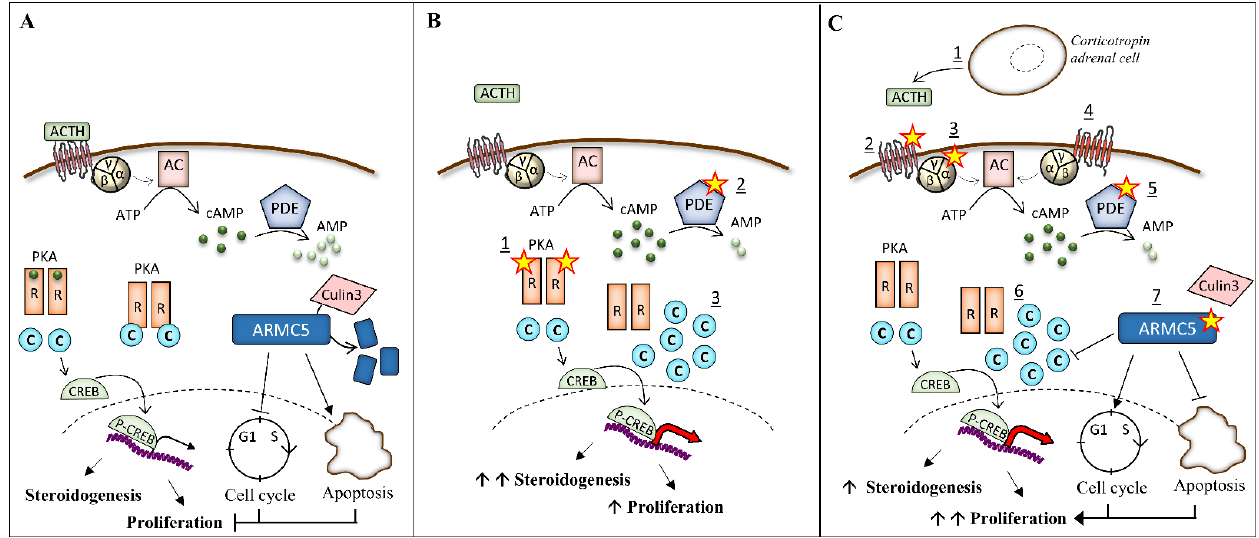
Figure 1. Alteration of protein kinase A (PKA) pathway and ARMC5 in bilateral adrenal hyperplasia. ( A ) In normal adrenocortical cells, ACTH activates the MC2R receptor, leading to the activation of the G α subunits of the G protein. The latter activates the adenylate cyclase (AC), which converts the ATP in cAMP. The phosphodiesterases (PDE) inactivates cAMP in AMP. The regulatory (R) subunits of the PKA bind the cAMP, leading to the release of the catalytic (C) subunits. The catalytic subunits phosphorylate their targets, including the cAMP Response Element-Binding protein (CREB), which activates genes involved in steroidogenesis. ARMC5 blocks the cell cycle in G1 phase and induces apoptosis. ARMC5 is degraded by Culin3. ( B ) In PPNAD and iMAD, the PKA pathway is activated by (1) mutations in the regulatory subunit R1 α of PKA, (2) mutations in phosphodiesterases genes, and (3) duplication of the catalytic subunit C α have also been described. ( C ) In PBMAH, the PKA pathway is activated by (1) ACTH locally produced by clusters of corticotropin adrenal cells, (2) mutations in the gene coding for MC2R, (3) mutations in gene GNAS coding for G α , (4) aberrant expression of G-coupled protein receptors, (5) mutations in phosphodiesterase genes, (6) duplication of the catalytic subunit C α , and (7) ARMC5 mutations, which lead to the activation of the cell cycle and the loss of apoptosis. Moreover, some mutations prevent its binding to Culin3 and its subsequent degradation. In addition, ARMC5 decreases the PKA activity.